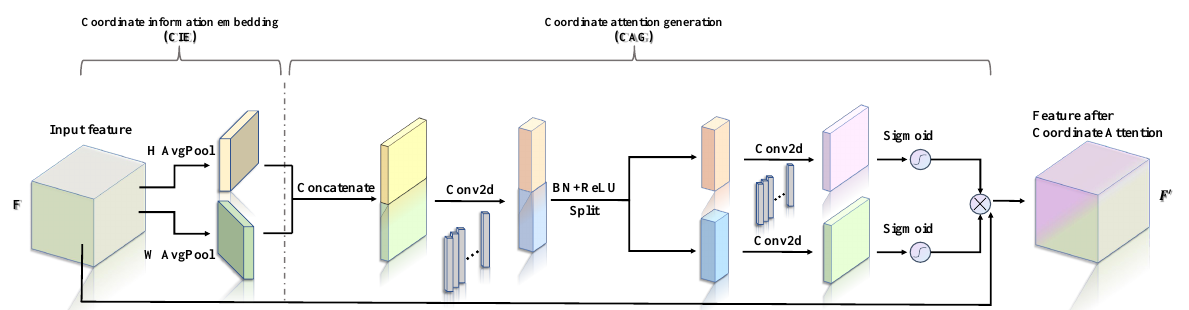
: multiplication operation Figure 5. The architecture of the coordinate attention (CA). It contains two parts, coordinate informa- tion embedding (CIE) and coordinate attention generation